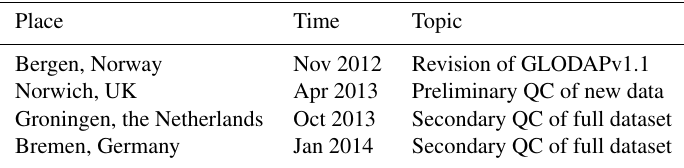
Table B1. Workshops conducted during GLODAPv2 production and their main topics. Place Time Topic Bergen,